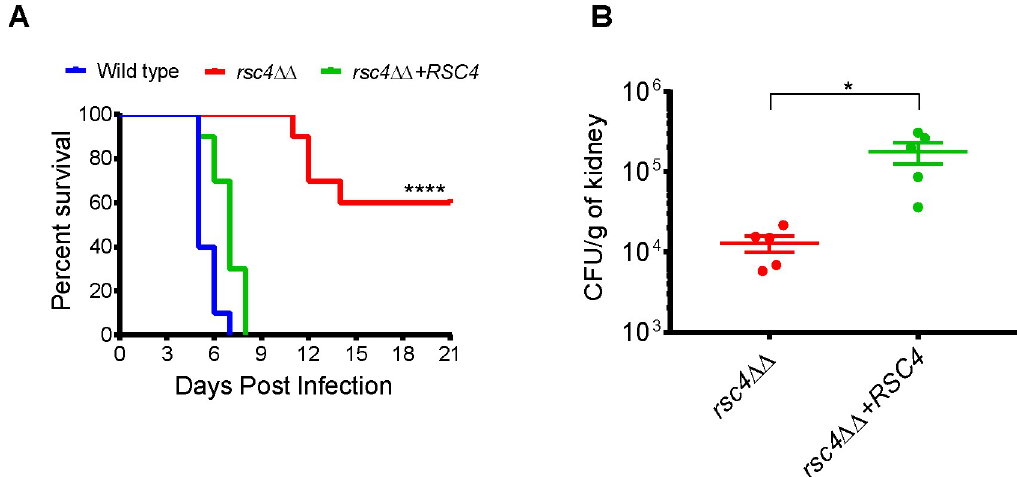
Fig 6. Rsc4 contributes to virulence of C . albicans in a mice systemic infection model. A. Survival kinetics of mice intravenously injected with 3X10 5 cells of wild type (SGC2024), rsc4 ΔΔ (SGC2022) and re-integrant strains (SGC2023). Statistical analysis was performed using Mantel-Cox test ( ���� p < 0.0001; 10 mice per strain). Raw data underlying graph given in S7 Table. B. Kidney fungal burden estimated from mice at 3 days post infection with the indicated C . albicans strains (5 mice/strain). Each data point represents the CFU/g of kidney tissue from individual mice of each category. Test of significance was performed using unpaired t test with Welch’s correction ( � p < 0.05). We have shown the complemented strain rather than the wild type as the positive control (see Materials and methods for details). Raw data underlying graph given in S7 Table.